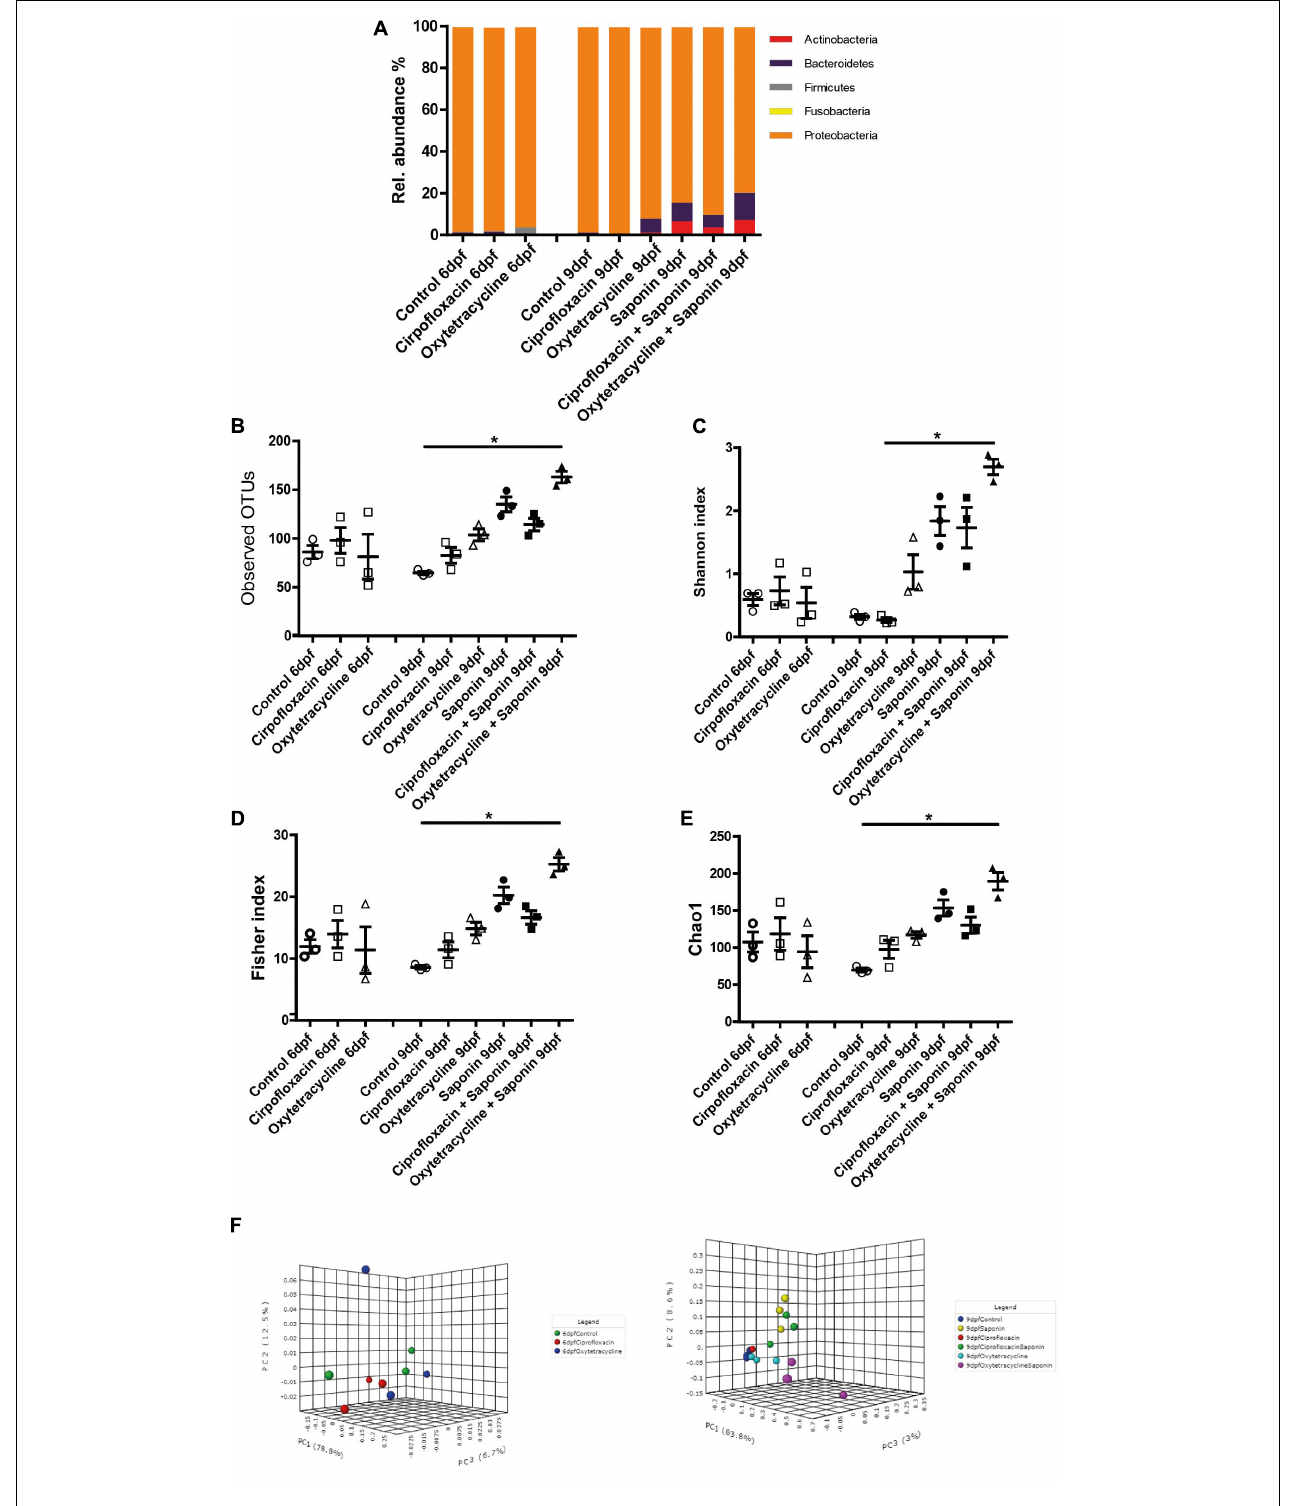
FIGURE 6 | Saponin altered the microbiome and co-exposure with oxytetracycline increased microbiota diversity. (A) Relative abundance in microbiota at phylum level for the treatment groups. Several richness and α -diversity indexes were analyzed: (B) Observed OTUs (richness), (C) Shannon’s diversity index, (D) Fisher index, (E) Chao1 index ( n = 3 pools of 5 larvae/treatment) (one way ANOVA Kruskal-Wallis test with Dunn’s Multiple comparison Post-Test, mean ± SEM, ∗ p < 0.05,). β -diversity PCoA plots are displayed for 6dpf (baseline) (F) and 9 dpf (end of the treatments exposure) (G) (Statistics: PERMANOVA).